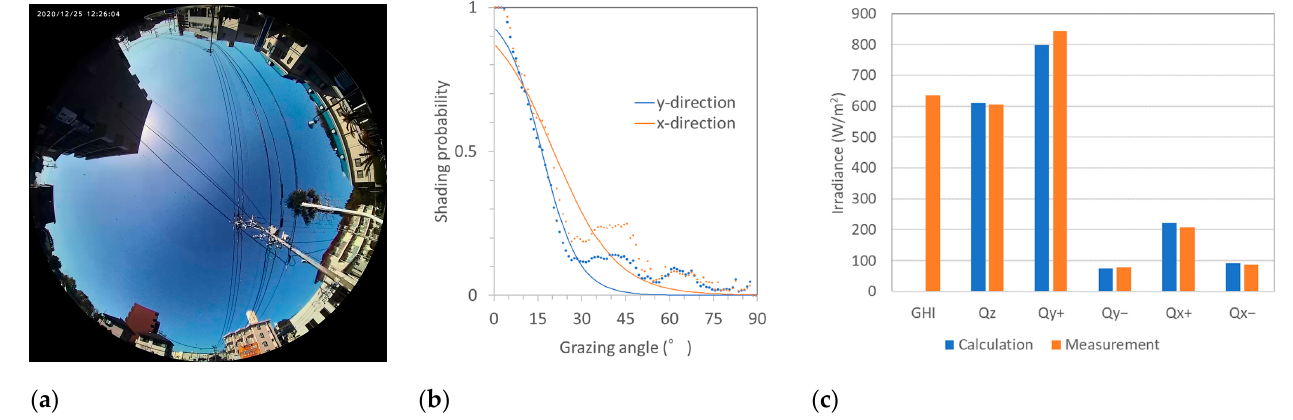
Figure 9. Shading distribution and irradiance onto VIPVs (5-axis) of the residential zone: ( a ) fisheye image; ( b ) shading probability as the function of the grazing angle; ( c ) comparison of the measured (red bars) and calculated (blue bars) irradiance onto 5-axis planes.